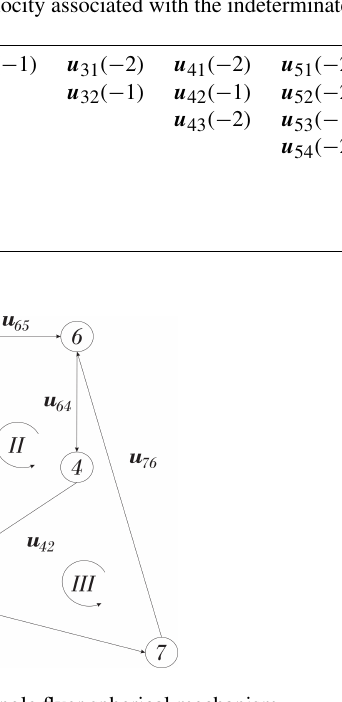
Figure 5. Directed graph of the single flyer spherical mechanism. of the kinematic pairs can be established so that the equa- tions necessary to solve the velocity analysis of the mech- anism shown in Fig. 4 are given by Eq. (9). It should be noted that if the origin, O , of the coordinate system is lo- cated in the common center of all the spheres, the velocity of the origin and the translational velocity components are always zero and do not need to be considered. Therefore, the velocity equations that involve the corresponding screws are reduced to the equations involving only the unit vectors as- sociated with the corresponding angular velocities.